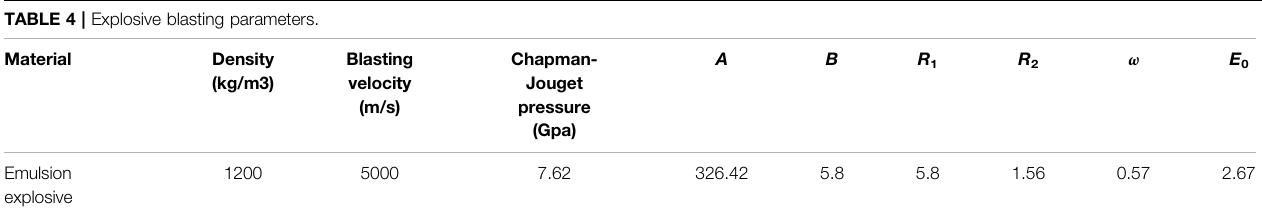
TABLE 4 | Explosive blasting